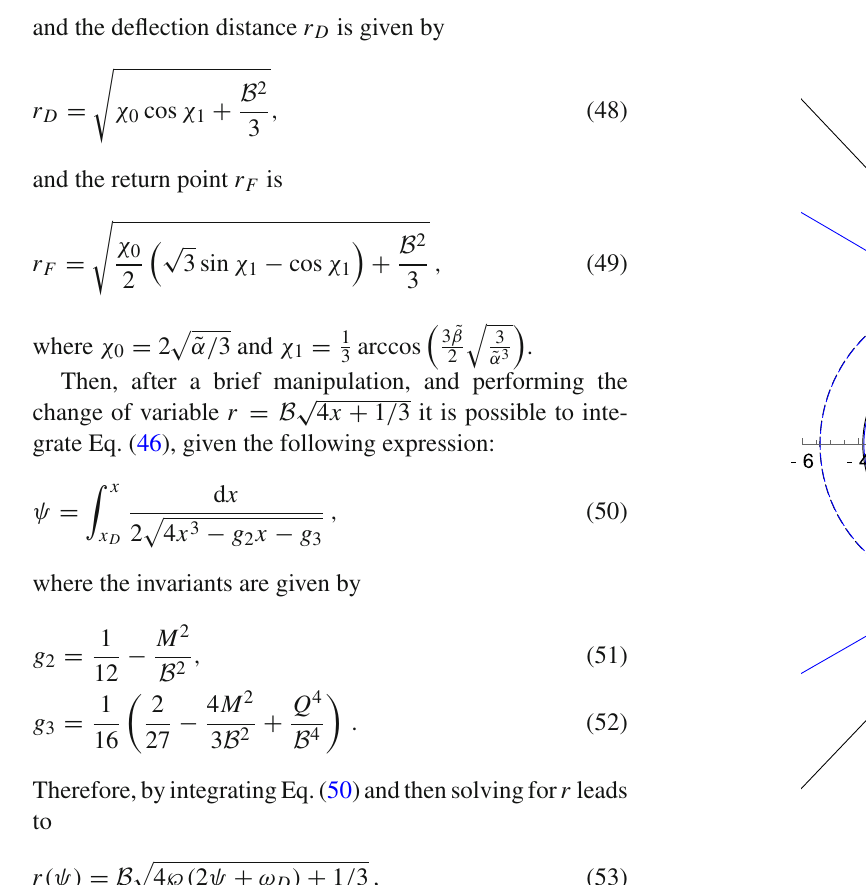
Fig. 5 Polar plot for deflection of light with (cid:4) = 10, and L = 1. Thin line E 1 = 0 . 07, thick line E 2 = 0 . 06, and dashed line E 3 = 0 . 04. Black lines for Q = 1 . 20 and blue lines for Q = 0